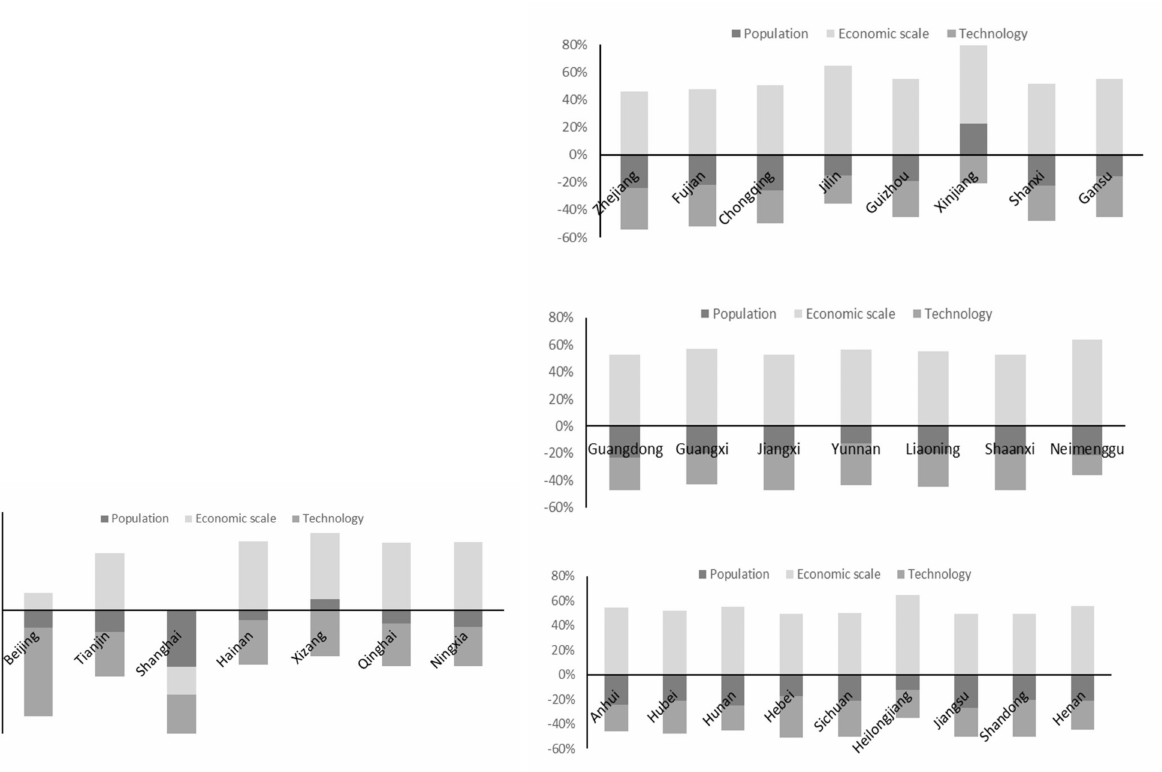
Figure 3. The contribution rate of various effects on carbon emissions from planting